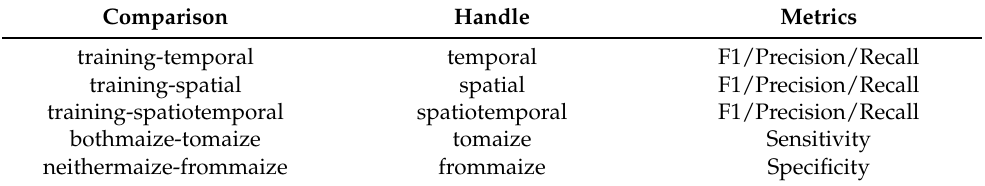
Table 3. Overview of Comparison